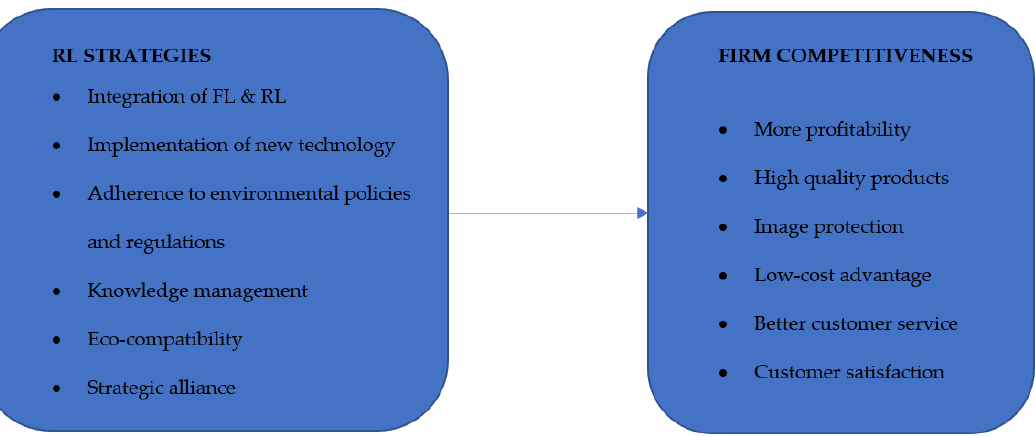
Figure 2. RL strategy conceptual framework.